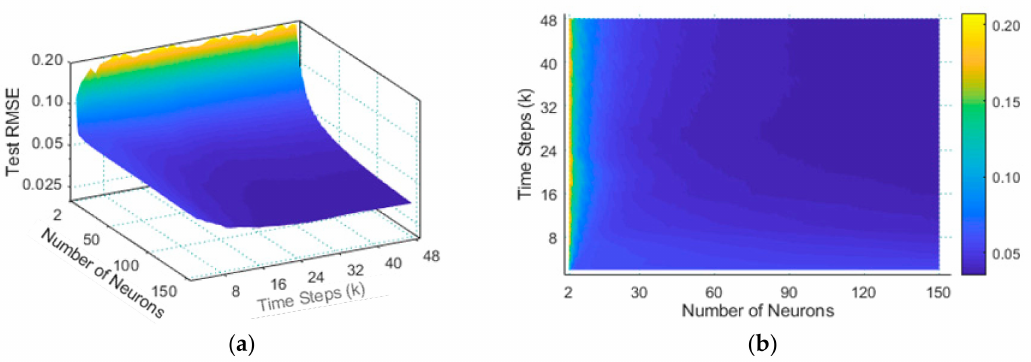
Figure 5. RMSE of v SVR and ε SVR when k takes di ff erent values. ( a ) The RMSE of v SVR; ( b ) The RMSE of ε